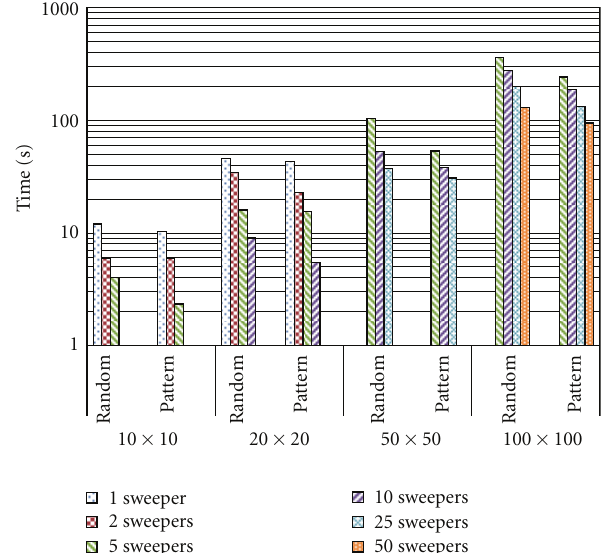
Figure 11: Time in random versus pattern-based distribution model.